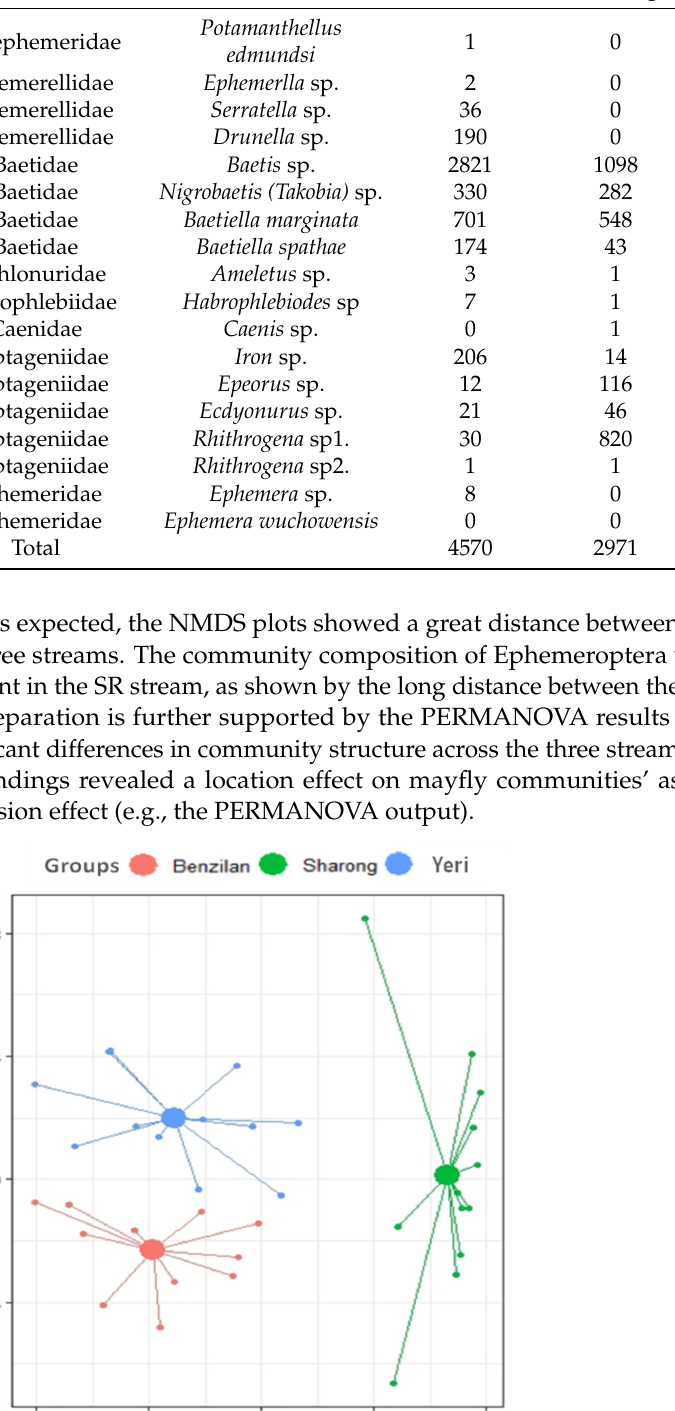
Figure 3. Non-metric multidimensional scaling (NMDS) plot based on Bray–Curtis dissimilarity index for the three analyzed streams, represented by colors. In this plot, it can be seen that the predicted centroid (larger-filled circles) distance displayed the similarity and dissimilarity between the three streams.